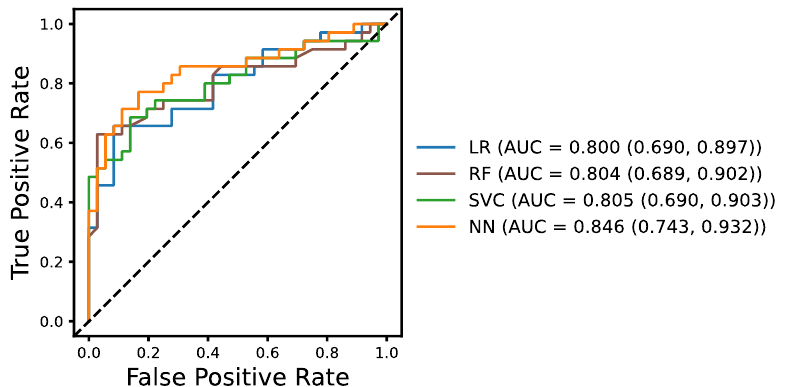
Figure 2. ROC curves for detecting AD using the data2vec from the ADReSSo unseen test set with random forest (RF), support vector classifier (SVC), logistic regression (LR), and neural network (NN) models. The mean AUC and the 95% confidence interval are reported for all four models.